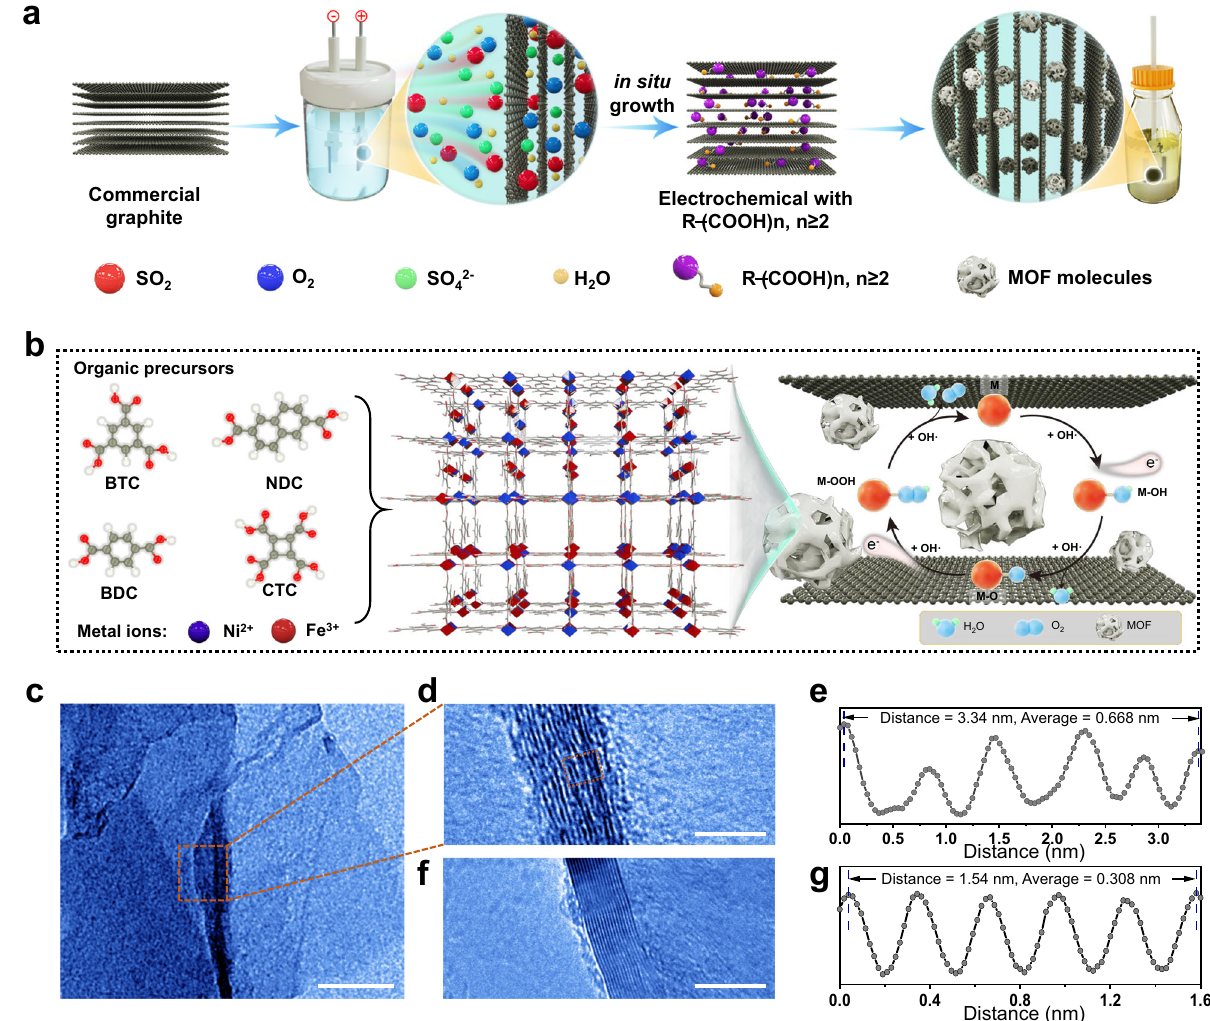
Fig. 1 | Synthesis and characterizations. Schematic illustration of a the electro- chemical synthesis process and b the resultant NiFe-MOF//G. c TEM image of the cross-section of NiFe-BTC//G. d A close-up of ( c ). f Cross-sectional view of